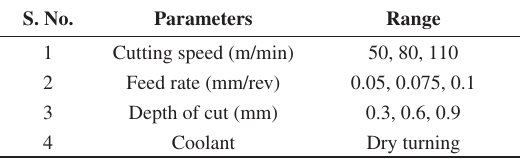
Table 2. Details of the cutting parameters used. S.